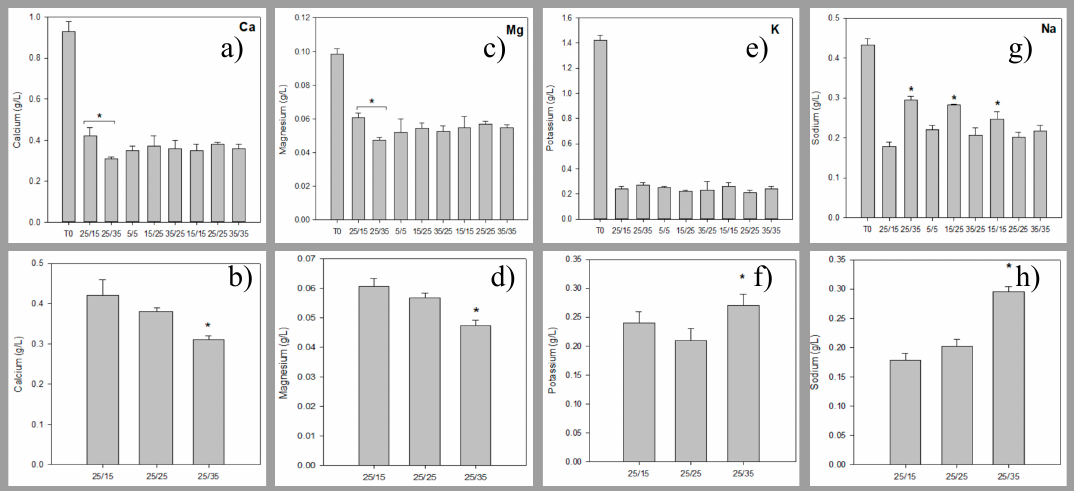
Figure 7. Mineral concentrations determined by inductively coupled plasma as atomisation and excitation source (ICP-OES) measurement (first line) for the eight PEF conditions tested and (second line) for the three conditions illustrating the pause duration variations during treatments: 25 s/15 s, 25 s/25 s, and 25 s/35 s. The minerals analysed were ( a , b ) calcium, ( c , d ) magnesium, ( e , f ) potassium, and ( g , h ) sodium. * there is significant statistical difference with other conditions (P < 0.05).